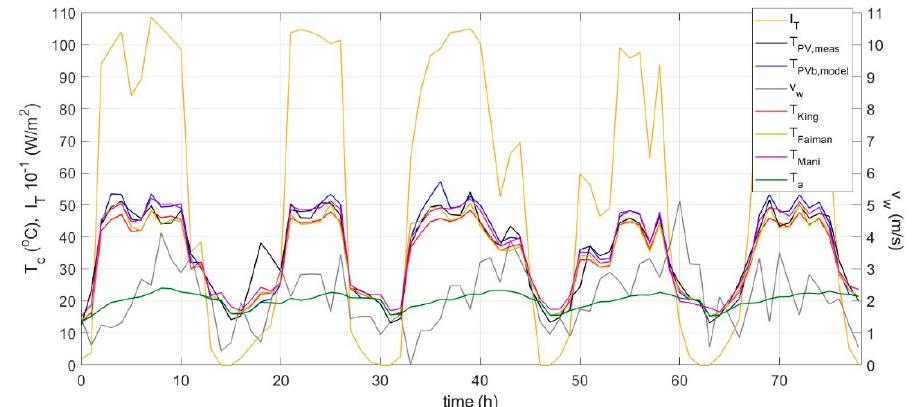
Figure 9. Predicted PV temperature profile by the proposed dynamic model compared to the measured temperature profile and the predicted temperature profiles generated by using 3 other models, for the sun-tracking PV system and during a period of 7 consecutive clear-sky days with time interval of 1 h. A further comparison is made with the temperature profile provided by the set of Equations (23)–(27).